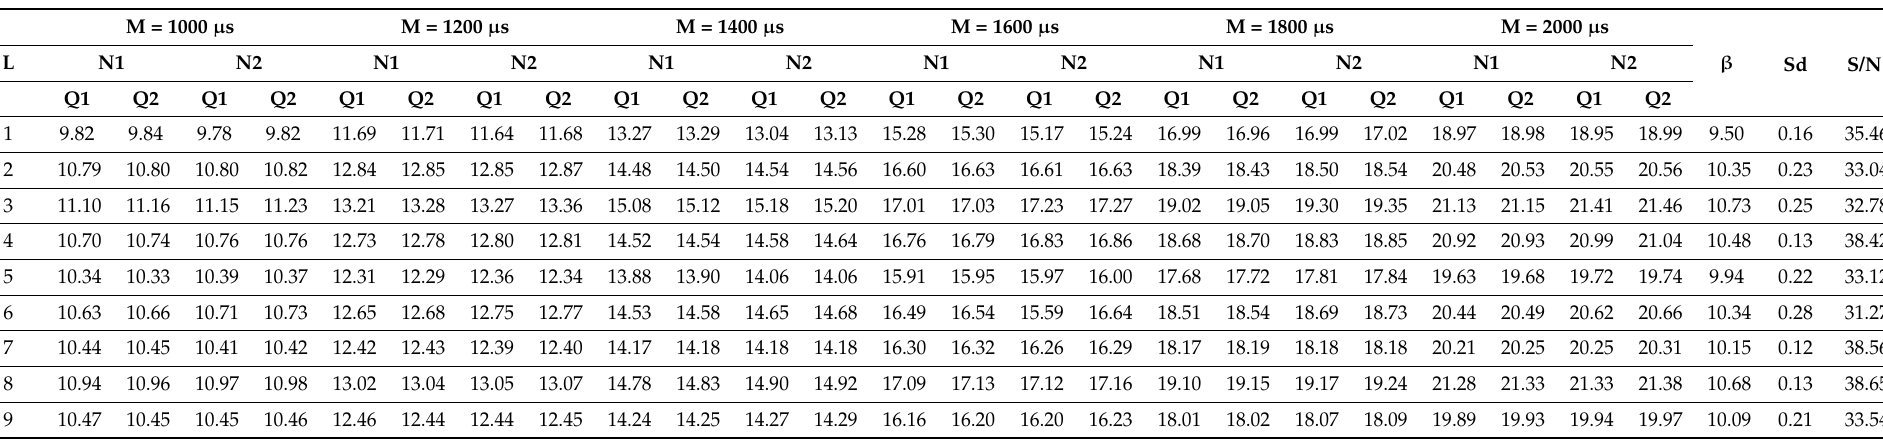
Table 1. Experimental data with orthogonal arrays and S/N ratios of control parameters for the fuel injection